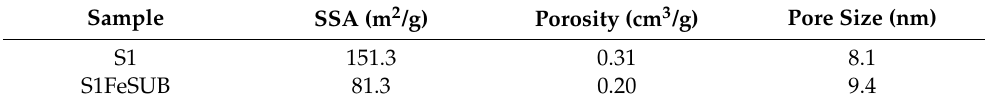
Table 3. Specific surface area of the S1 and S1FeSUB sample powders after calcination for 5 h at 500 ◦